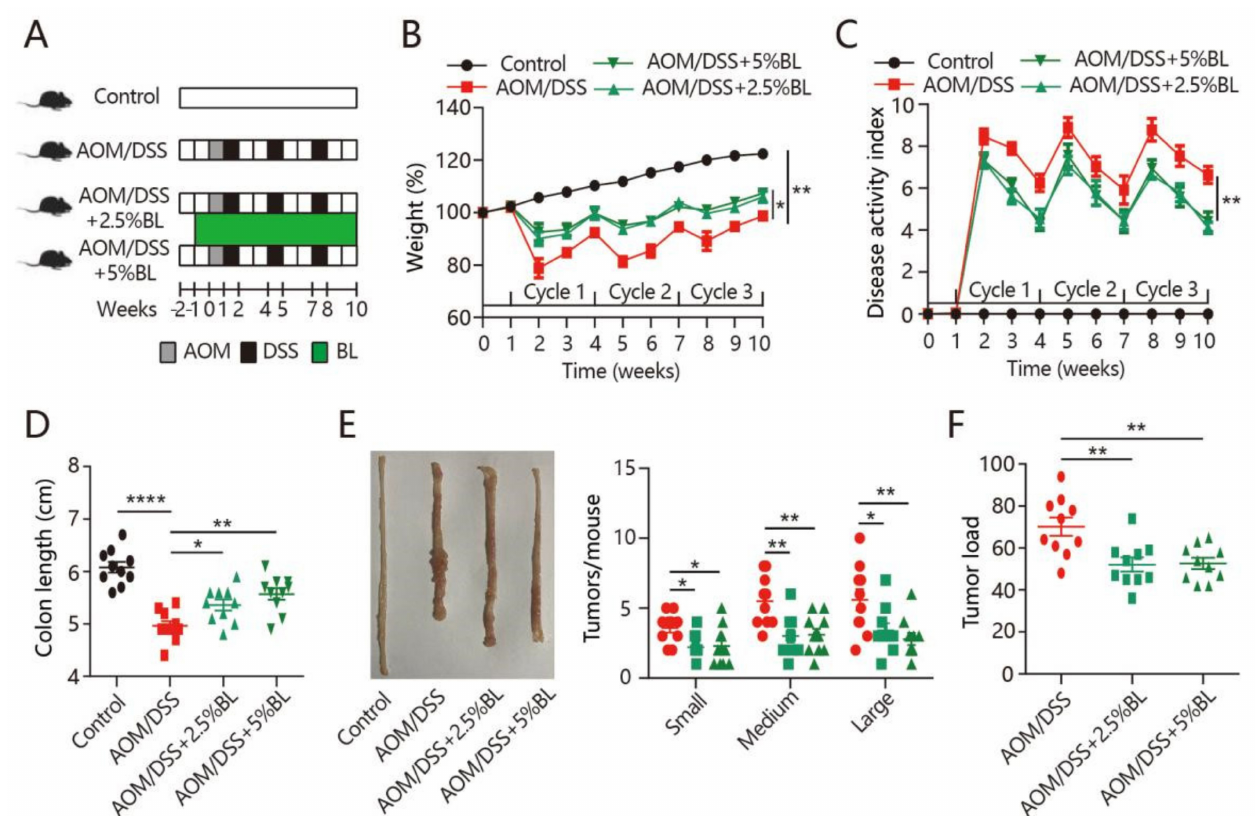
Figure 1. BL attenuates AOM/DSS-induced colorectal cancer. ( A ) Experimental protocol for intervention timeline and induction of colitis-associated colon carcinogenesis. ( B ) Percentage weight change, ( C ) disease activity index, ( D ) colon length, ( E ) representative morphologies of colon and tumor number, and ( F ) tumor load from different mouse groups were measured ( n = 10). Data are expressed as mean ± SEM. ( B , C ) Two-way ANOVA. ( D – F ) One-way ANOVA. * p < 0.05, ** p < 0.01, and **** p < 0.0001. BL, barley leaf; AOM, azoxymethane; DSS, dextran sodium